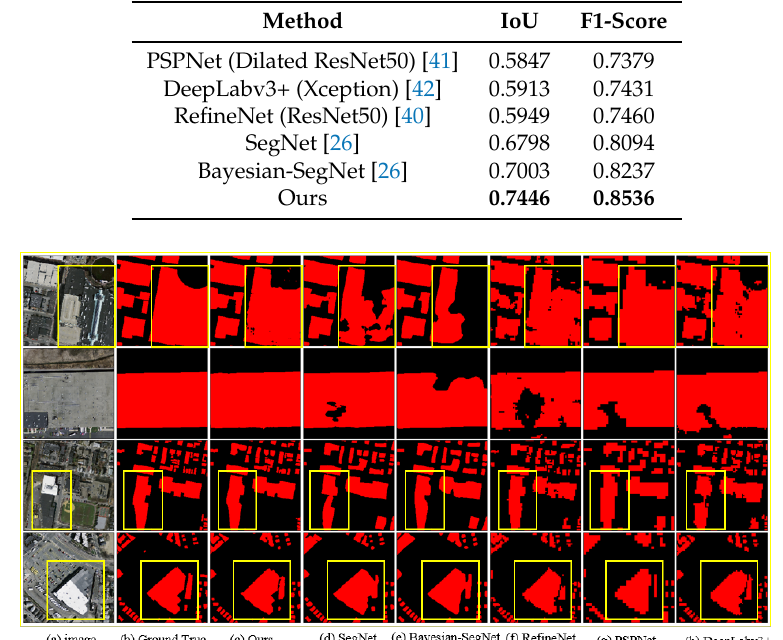
Table 3. Experimental results of our method and five other state-of-the-art methods.